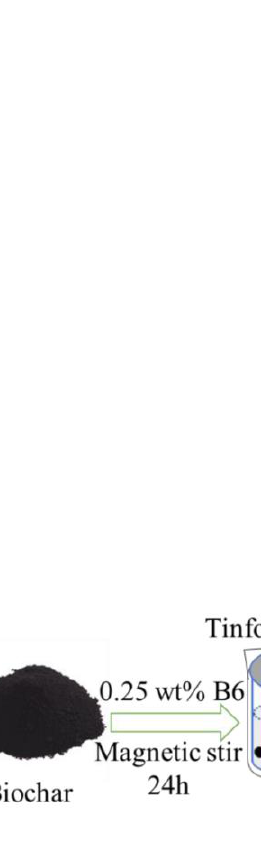
Figure 1. Flow chart of nZVI/B6@BC